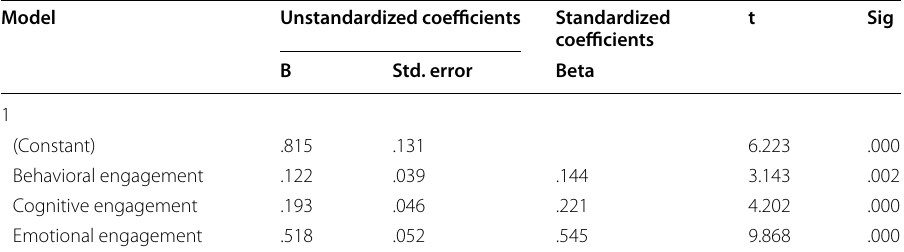
Dependent variable: educational technology engagement a Predictors: (constant), emotional engagement, behavioral engagement, cognitive engagement Table 6 Regression analysis results of three engagement dimensions on educational technology